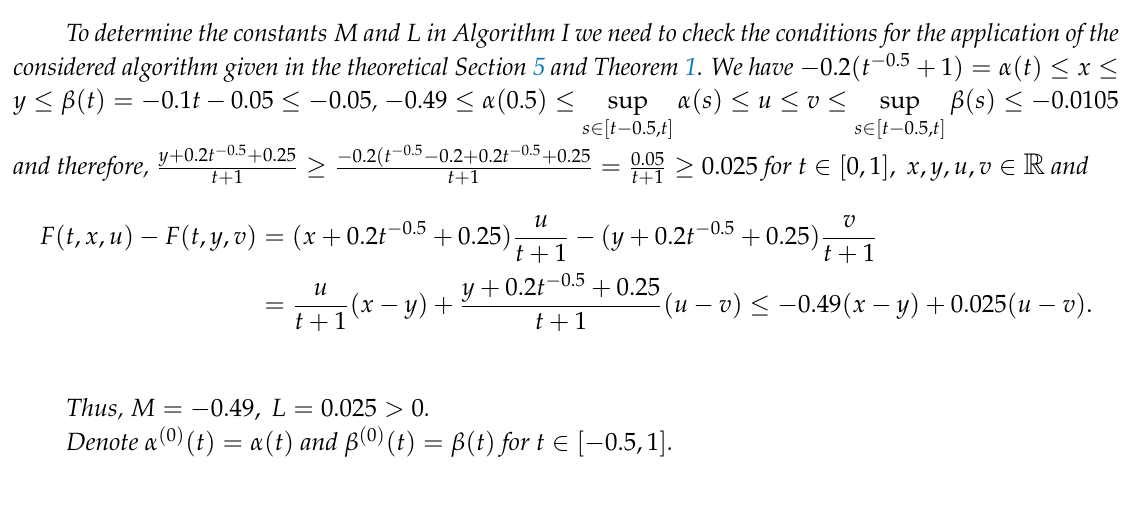
Figure 6. Graphs of the functions β ( t ) and α ( t )